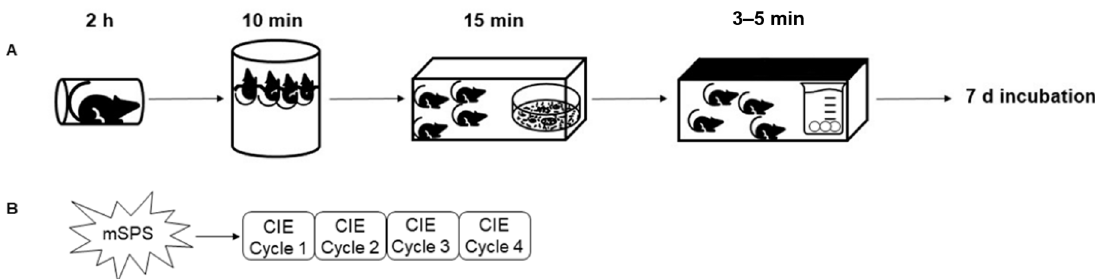
Scheme 1. Schematic overview of ( A ) the mouse single prolonged stress (mSPS) paradigm, ( B ) mSPS-CIE consecutive cycles paradigm. After mSPS paradigm and 7 days incubation, mice were exposed to 4 consecutive cycles of CIE